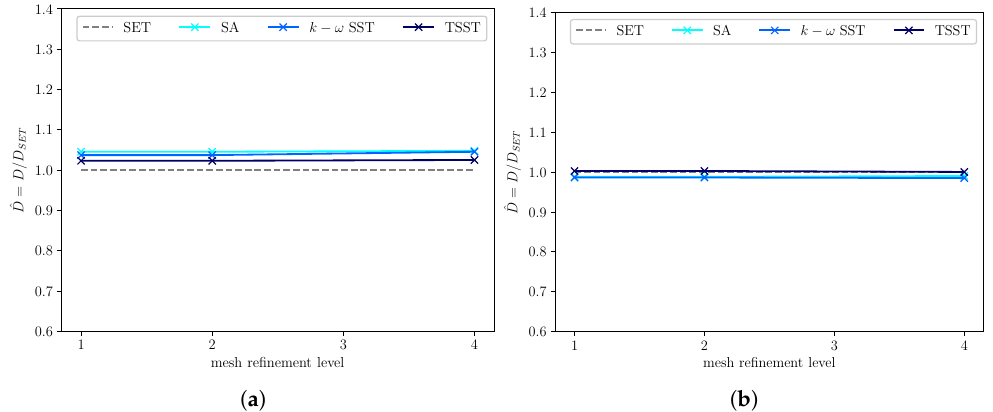
Figure 4. Comparison between the SET and the CFD-computed drag coefficient along with the first and the second ramps as a function of the turbulence model and the mesh refinement level. ( a ) Drag coefficient (ramp 1); ( b ) Drag coefficient (ramp